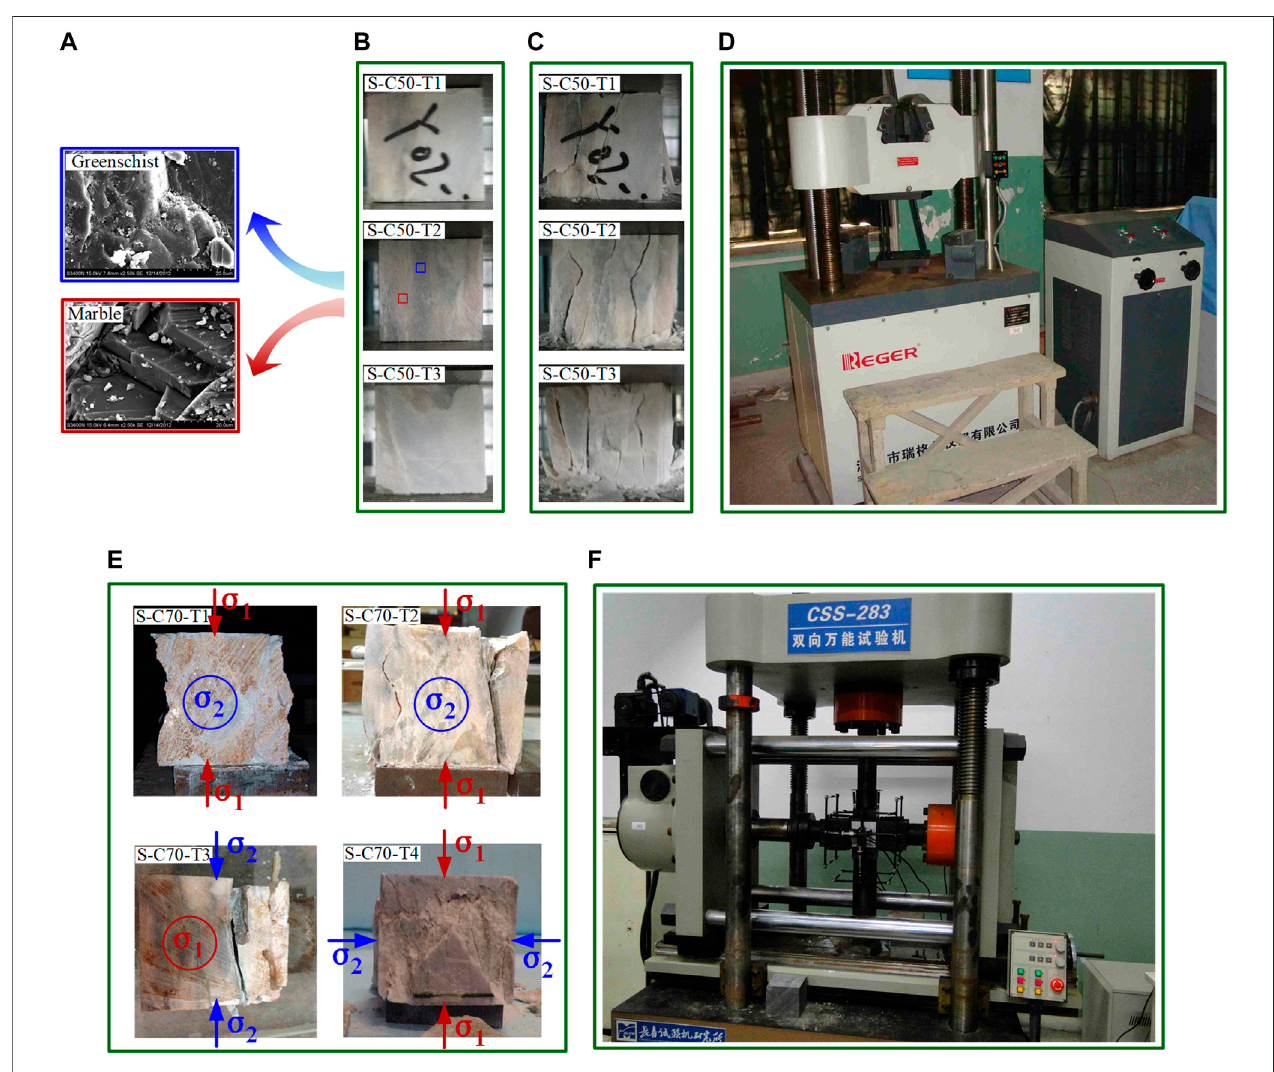
FIGURE 1 | Laboratory experiments of multiaxial compression failure.